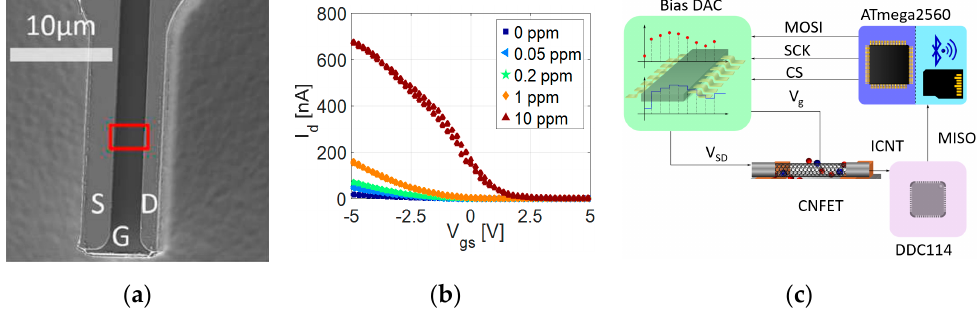
Figure 1. ( a ) SEM of SWCNT (inside the red square) [reprinted with permission from IEEE] [3]; ( b ) SWCNT-FET transfer characteristic under various NO 2 gas concentrations at V ds = 0.5 V; ( c ) block schematic of the